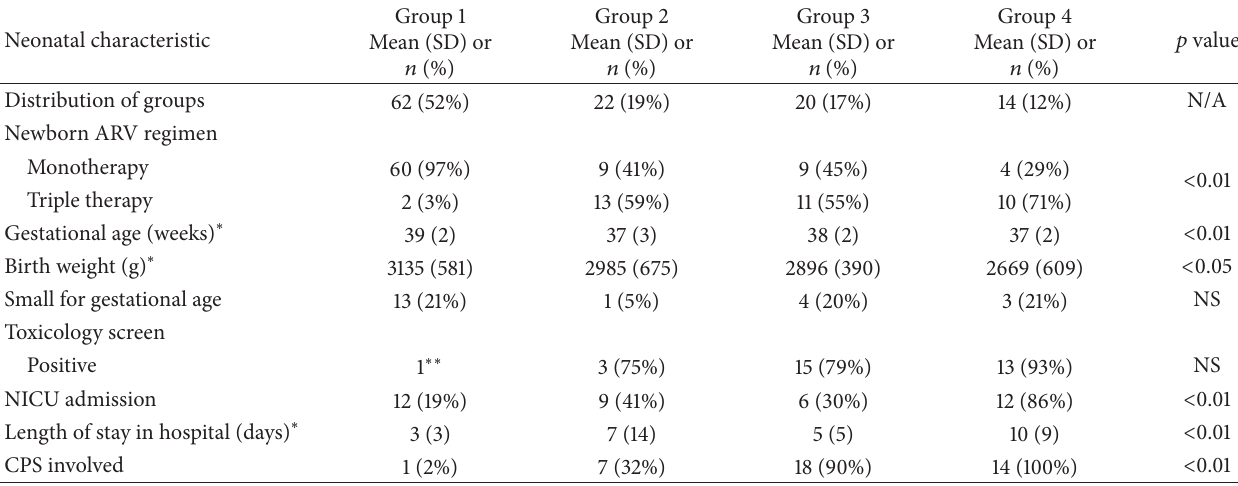
Table 5: Summary of groups in secondary analysis and differences in neonatal characteristics between